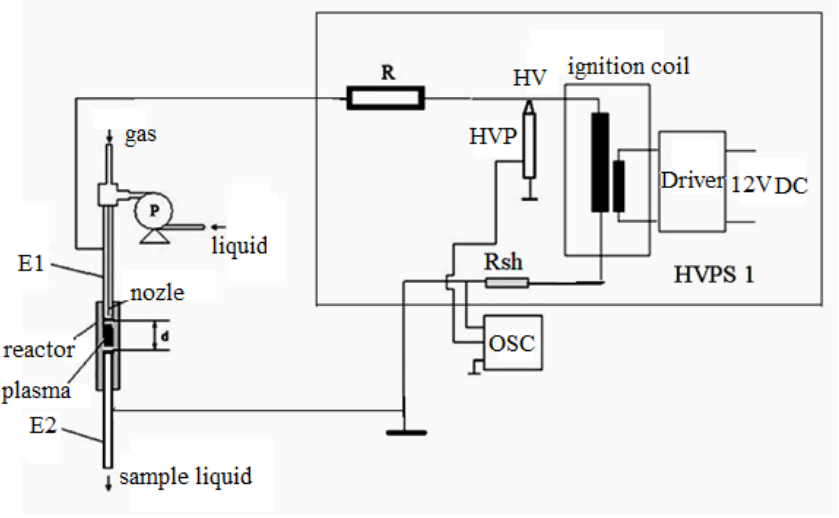
Figure 1. The schematic of NTP reactor powered by a pulse induction coil power supply (ICR).